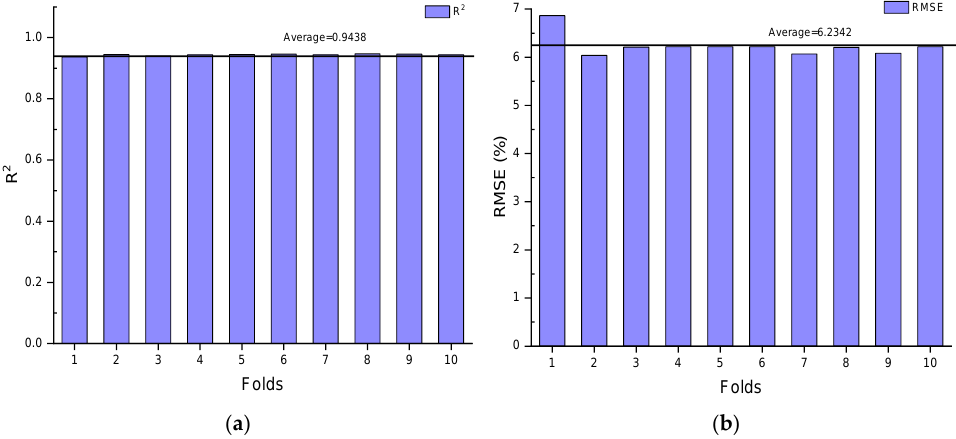
Figure 3. ( a ) R 2 results and ( b ) RMSE results of GBR models with the 10-fold cross validation for predicting HP of BSHC. Table 4. R 2 and RMSE results of GBR models with the 10-fold cross validation.